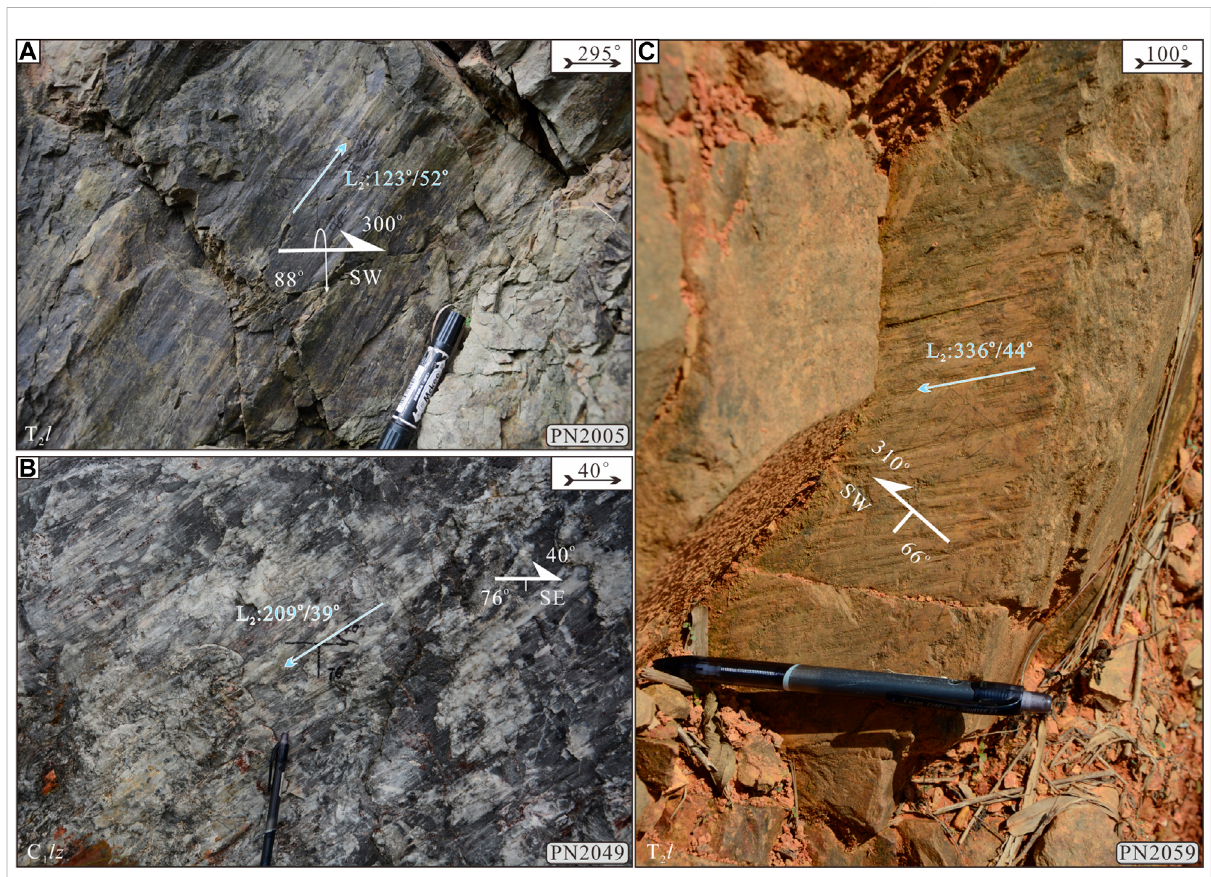
FIGURE 4 Field photographs of main structures developed in the D 2 deformation in the YFTB. (A) Sinistral striations and mineral steps on the hanging wall of the NW-striking fault plane in the siltstone of the Triassic Lanmu Formation at PN2005. The striations and mineral steps imply the top-to-the downward shear. (B) Striations and calcite mineral steps on the inter-bedding fault plane in the chert of the Carboniferous Luzhai Formation at PN2049 indicating a top-to-downward movement. (C) Striations developed on the NW-striking fault plane at PN2059 indicating top-to- downward